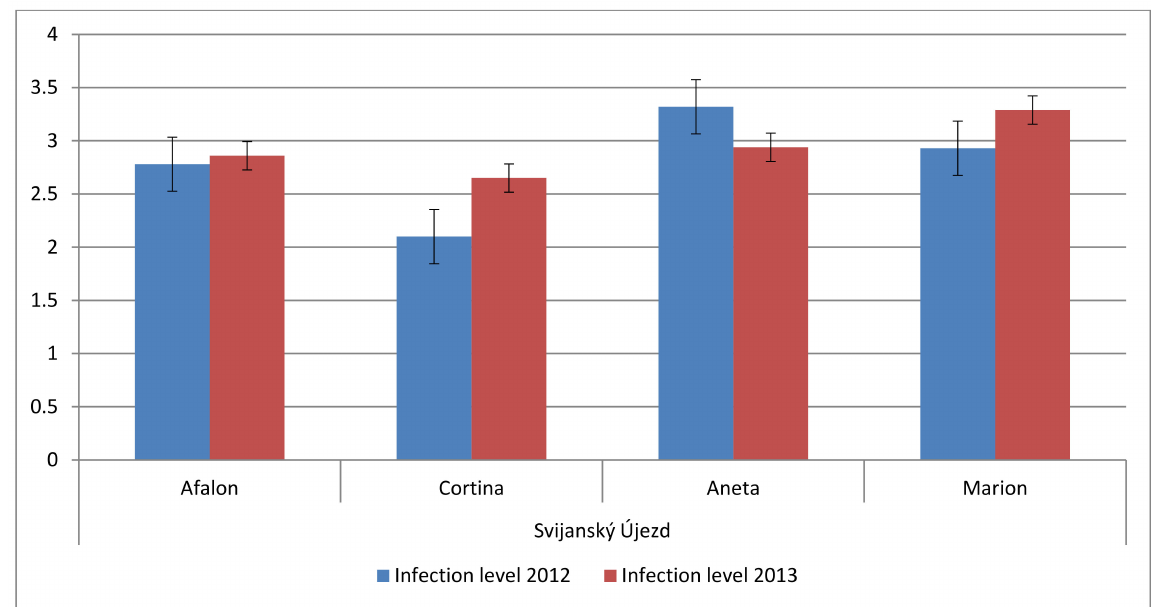
Figure 7. Comparison of spontaneous infection level in various carrot cultivars at the Svijansk ý Ú jezd locality, grown conventionally at the seeding density of 9 × 10 5 seeds ha − 1 in 2012 and 2013; the level of spontaneous infection is expressed in arbitrary